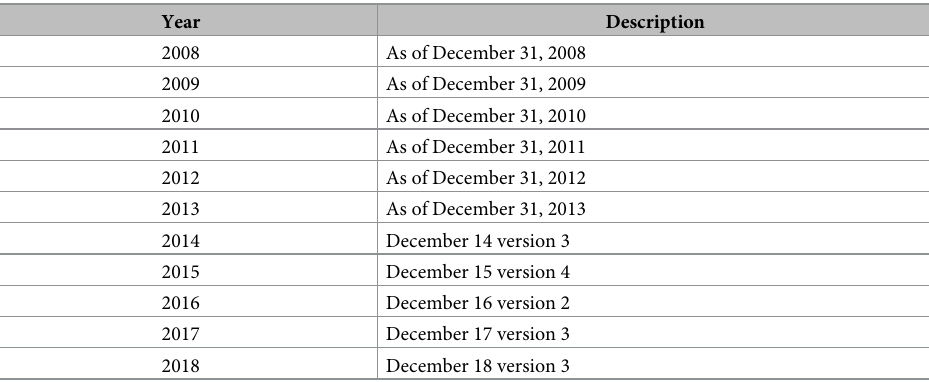
Table 1. Versions of data